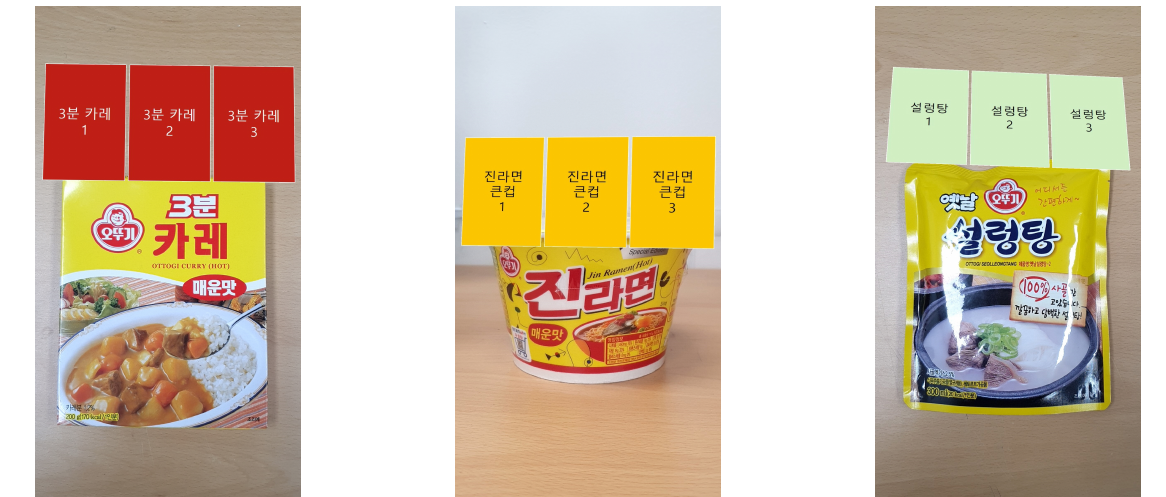
Figure 2. Example application screen showing Augmented Reality (AR) contents for the target products. Two-dimensional card images include the product name in Korean: 3-minute Curry for the left one, Jin Ramen large cup for the middle one, and Seolleongtang for the right